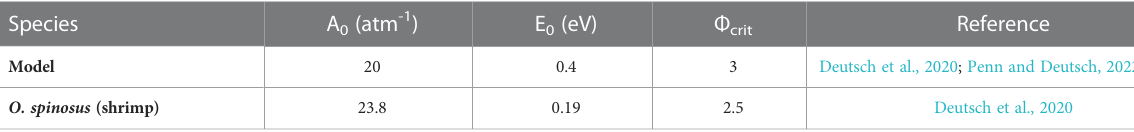
TABLE 1 Physiological traits (A 0 and E 0 ) and Ф crit of the model species and O. spinosus .